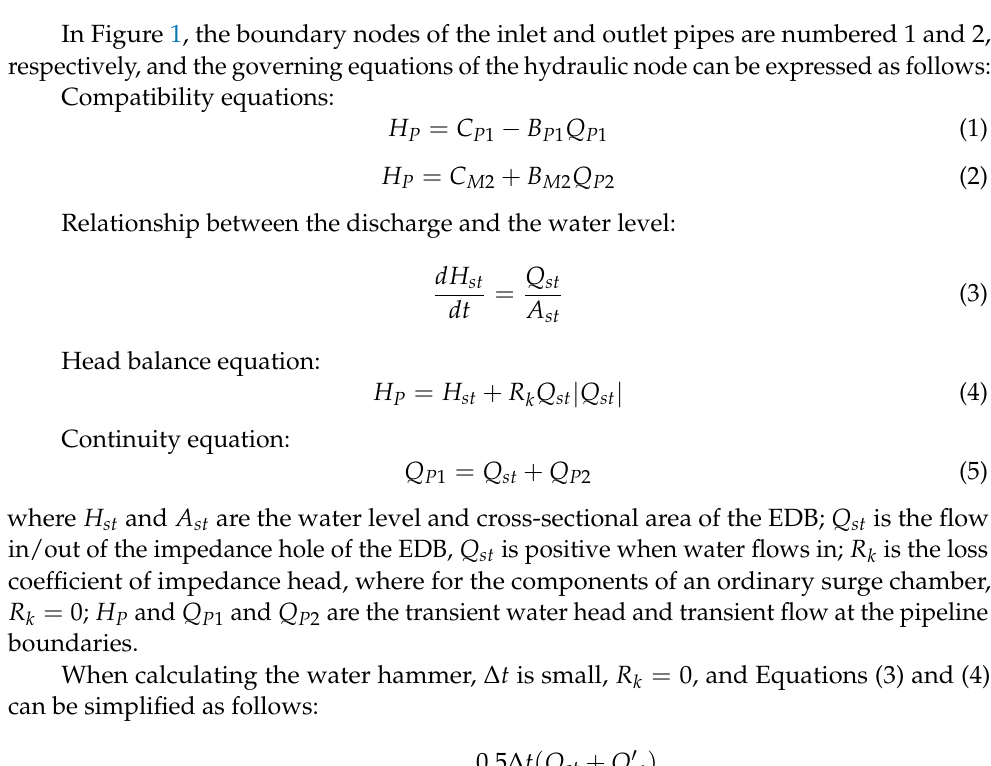
Figure 1. Schematic diagram of a mathematical model of energy dissipation boxes